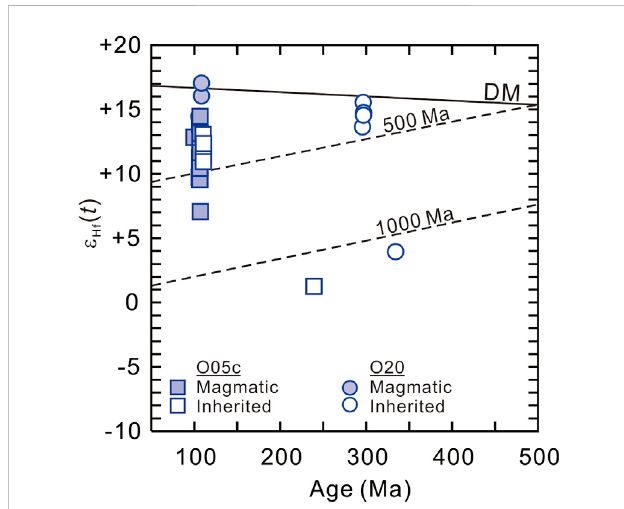
FIGURE 6 Zircon Hf isotopic evolution of the diorites (O05c, O20) from the Snoul pluton. The evolution curves (dashed lines) are calculated assuming Lu/Hf crustal value of 0.015 (Grif fi n et al., 2004; Chauvel et al., 2008). DM = depleted